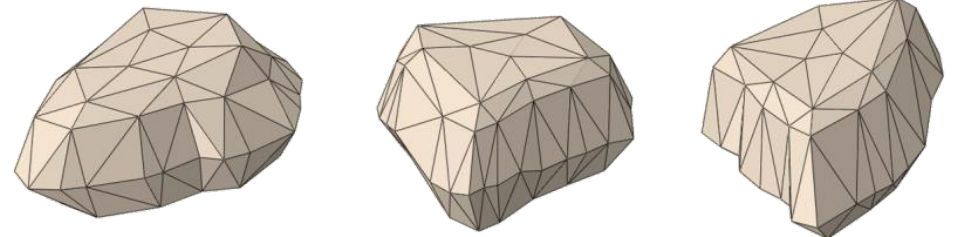
Figure 3. Several instances of generated three-dimensional aggregates. (6) In the three-dimensional boundary of the heterogeneous model of asphalt concrete, based on a given gradation, small balls were randomly distributed with corresponding particle sizes by PFC3D. We imported the STL-formatted three-dimensional aggregate template created in the earlier step. Then, the small balls were randomly selected within the boundary range of the heterogeneous model, and the small balls were replaced with three-dimensional aggregate with the same shape center and volume as the balls. The operation was repeated until all the small balls were completely replaced. An example of aggregate positions in the three-dimensional heterogeneous model is shown in Figure 4.